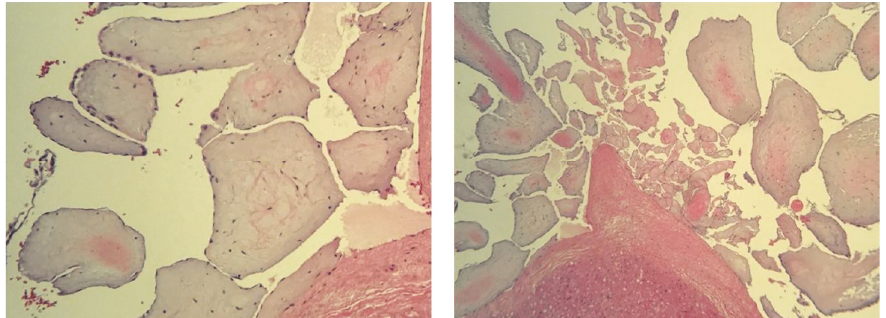
Figure 5: H and E stain of the excised right atrial mass showing fragments of the myocardium and multiple free floating papillary structures. The outer surface of these papillary structures is lined by endothelial cells. The stroma is fibroelastic with prominent myxoid changes. These findings are consistent with papillary